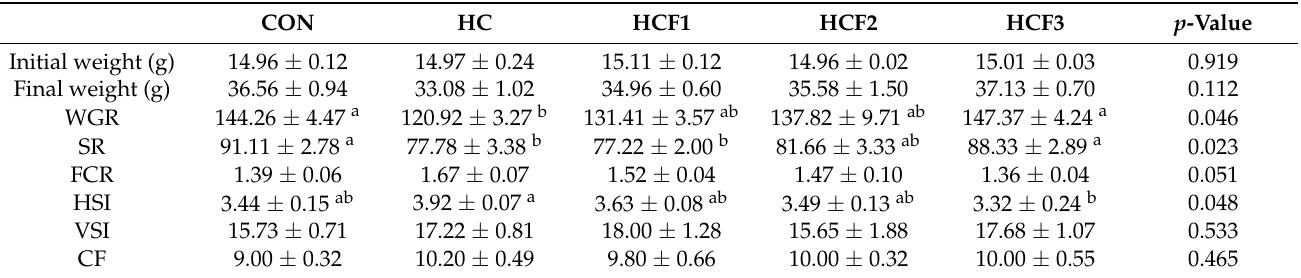
Table 3. Effects of dietary mulberry leaf flavonoids on the growth performance of Monopterus albus fed high-carbohydrate diets (mean ±